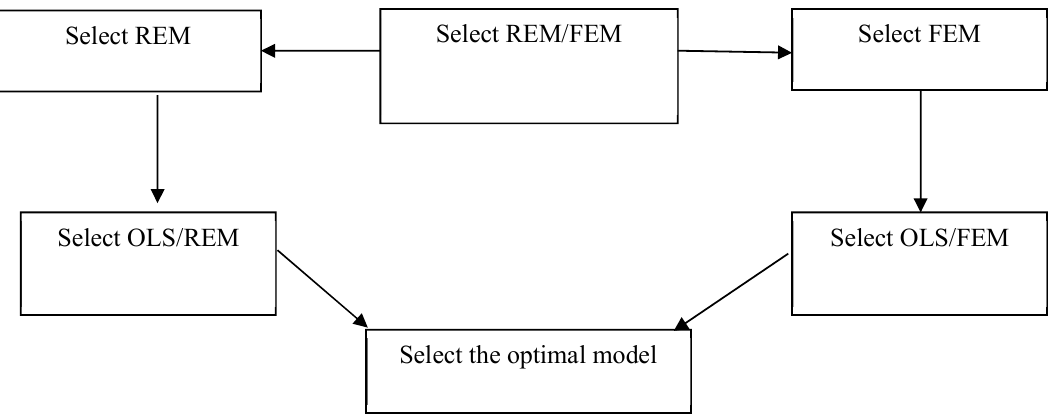
Fig. 1. The process of selecting the optimal regression model